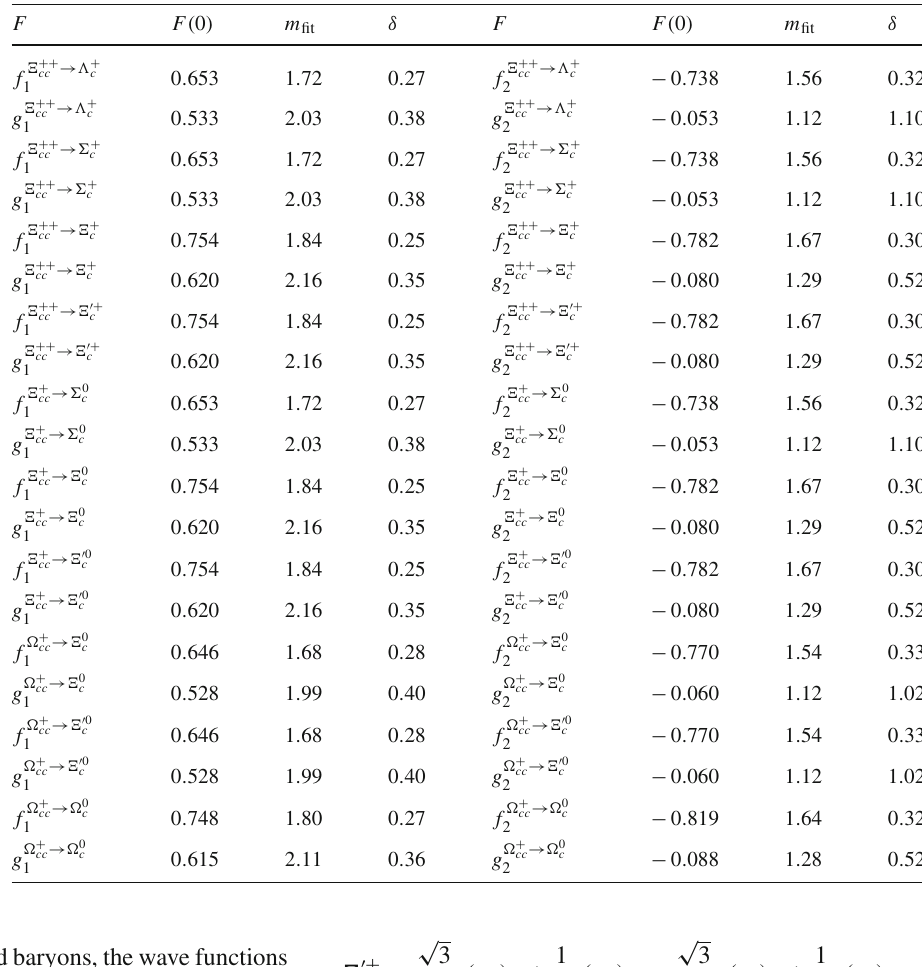
of doubly charmed baryon decays with scalar (0 + ) diquarks. The formula of (35) is